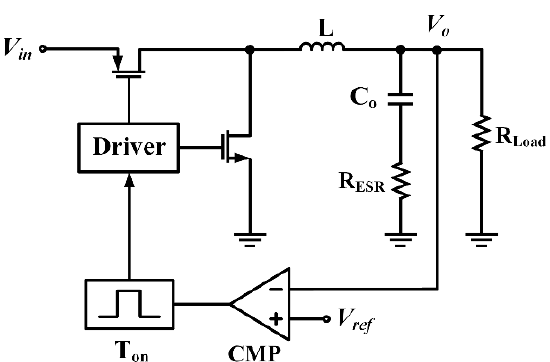
Figure 1. Conventional ripple-based constant on-time (RBCOT) buck converter.